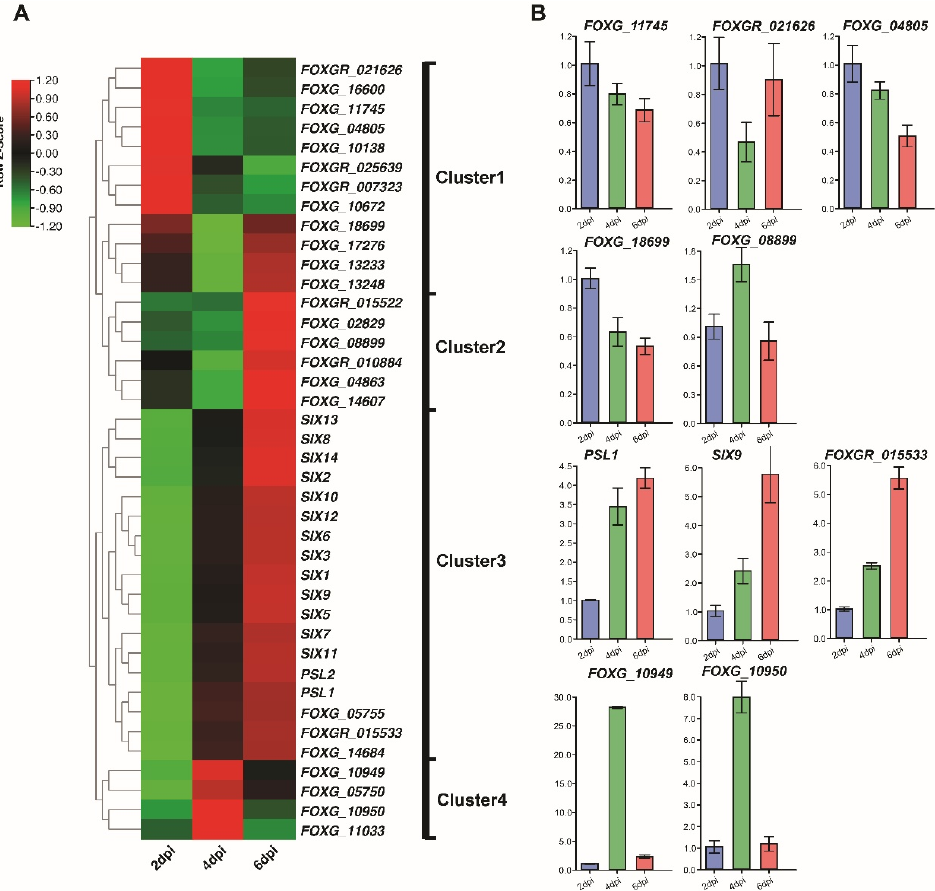
Figure 3. Expression profiles of effector candidate genes and the validation of the expression of selected effector candidate genes during Fol infection by RT-qPCR. ( A ) Clustered heatmaps of the 40 differentially-expressed Fol effector candidate genes at 2, 4, and 6 dpi based on RNA-seq data. The row color scale reflects the values of log2 (mean TPM at each time point), in which red represents higher expression and green represents lower expression. Genes are grouped into four clusters with distinct expression profiles over the three-time points. ( B ) Quantitative RT-PCR analysis showing the expression of effector candidate genes selected from each cluster in infected tomato roots at 2, 4 and 6 dpi. Fol actin was used as an internal reference gene and expression levels were normalized to actin. Values are means of three independent biological samples and error bars represent standard deviations.